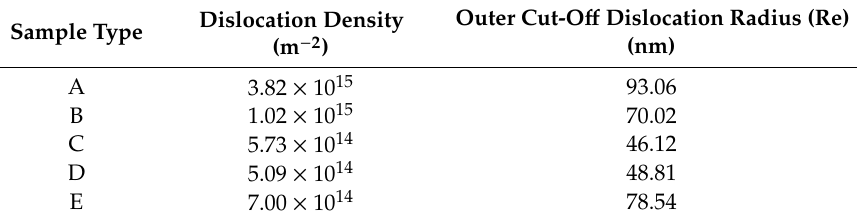
Table 5. The density and e ff ective outer cut-o ff dislocation radius resulting from the MWA method.